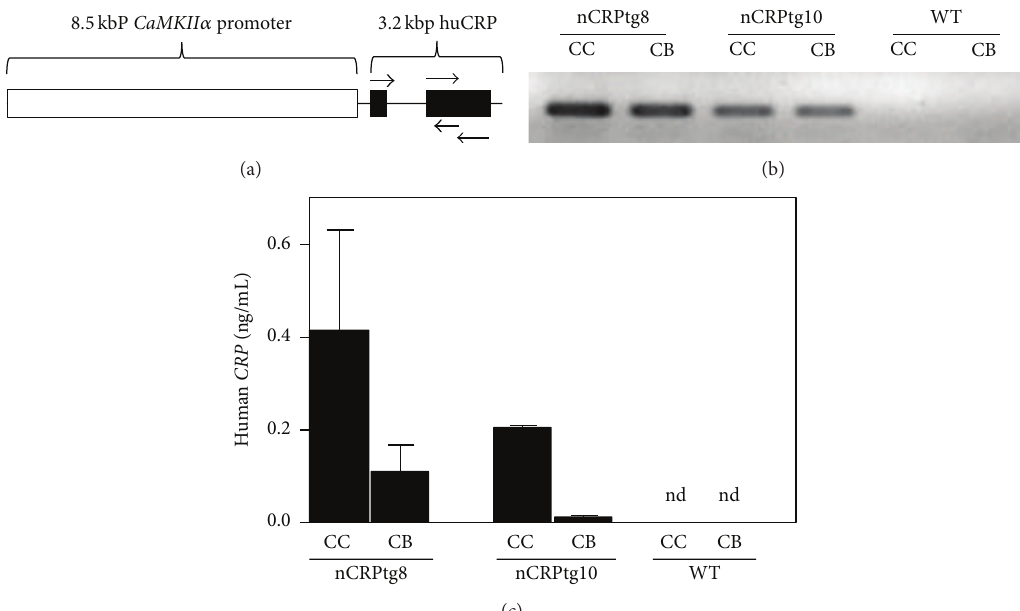
Figure 1: The nCRPtg construct and generation of nCRPtg mice. (a) The transgene comprises the protein coding region of the human CRP gene (huCRP; black boxes) fused to the mouse Ca 2+ /calmodulin-dependent protein kinase 𝛼 ( CaMKII 𝛼 ) gene promoter (open box). Small arrows indicate the approximate positions and directions of elongation of the intron-flanking sense and antisense primers used to ensure proper CRP mRNA processing, and the large arrows show the location of primers used to genotype mice. Horizontal dimension is not to scale. (b) Agarose gel electrophoresis of amplification products generated by human CRP specific qRT-PCR. mRNA for qRT-PCR was isolated from the cerebral cortex (CC) and cerebellum (CB) and qRT-PCR was performed using primers that flanked the CRP intron (small arrows in (a)). The size of the resulting reaction product ( ∼ 290bp) indicates excision of the intron. (c) Enzyme linked immunosorbent assay of cerebral (CC) and cerebellar (CB) homogenates from the same mice shown in (b). nd, not detected. WT, wildtype